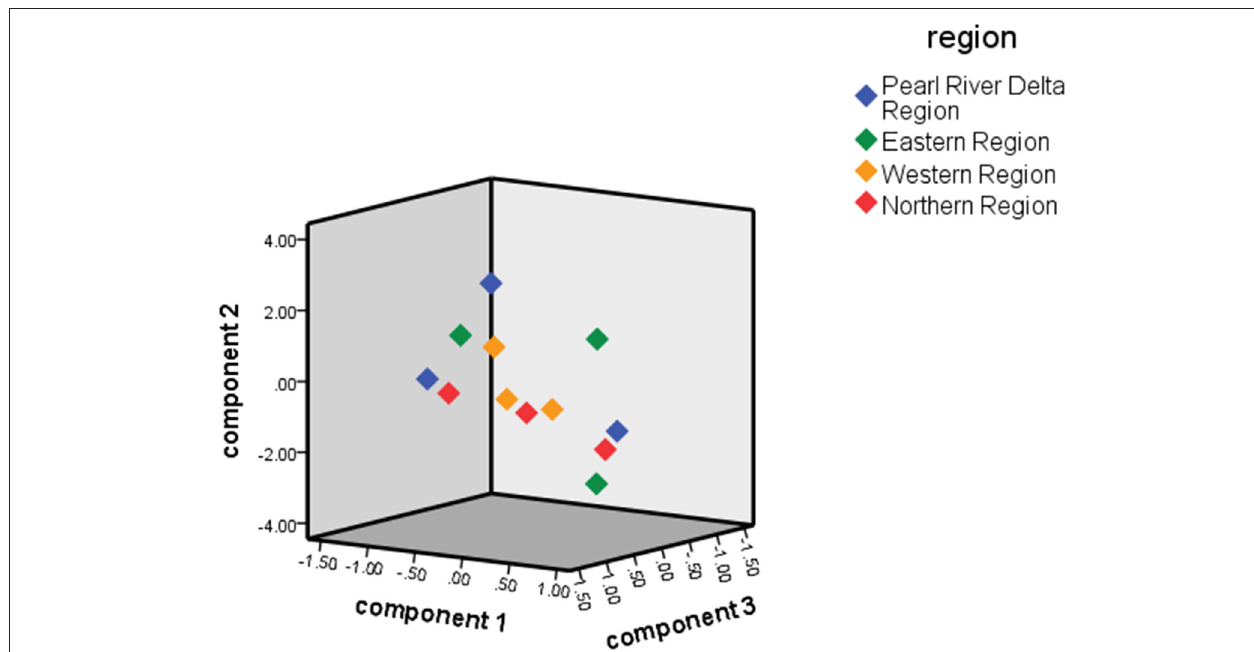
FIGURE 3 | Traditional Chinese medicine hospital.